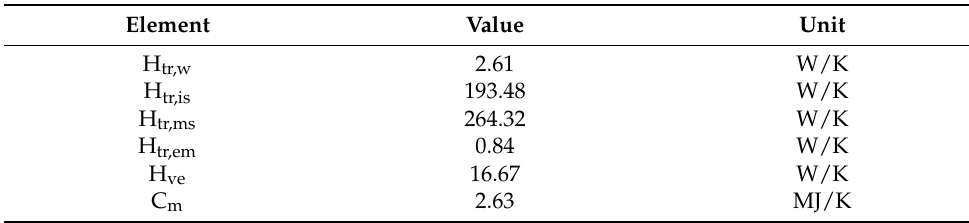
Table 2. Thermal network model elements of the building.